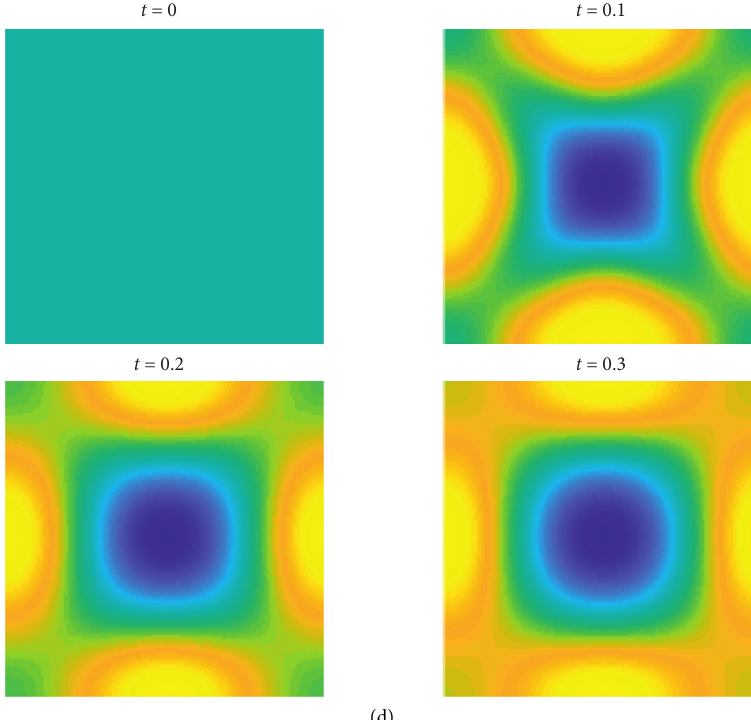
Figure 10: Numerical solution and Turing pattern of Experiment 2 with initial condition u ( x,y, 0 ) � sec h ( π (− x 2 + y 2 )) and v ( x,y, 0 ) �